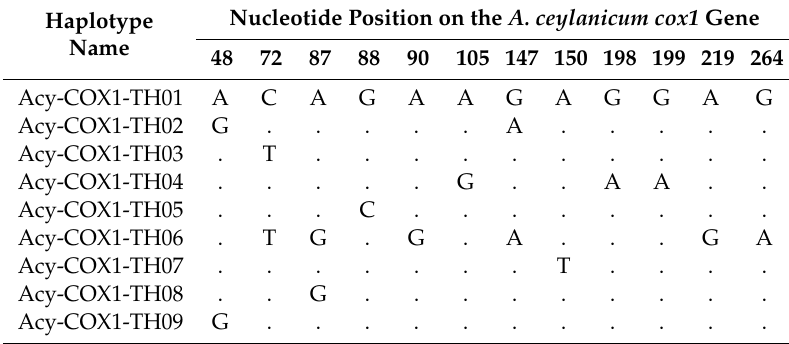
Dots indicated the matching of nucleotide position the A. ceylanicum